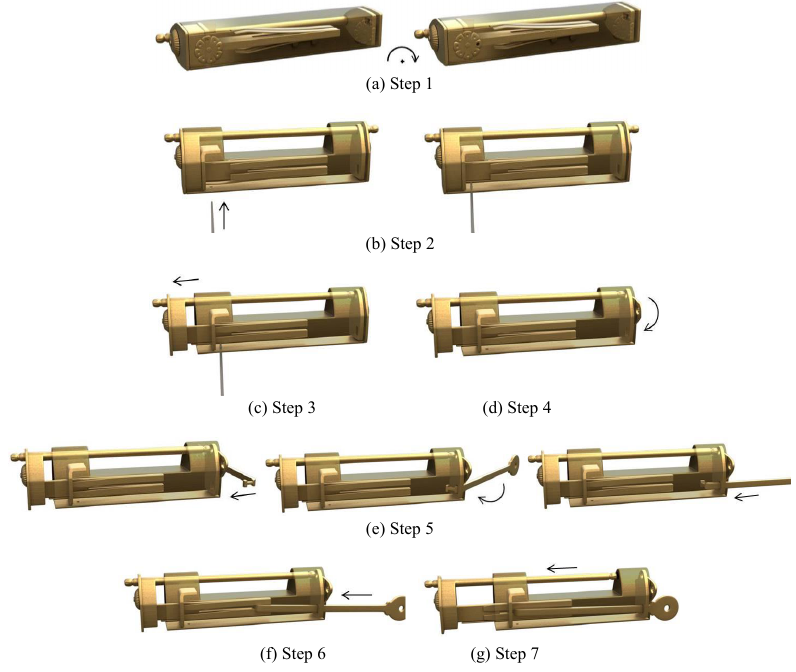
Figure 10. Animation of padlock with a rotating